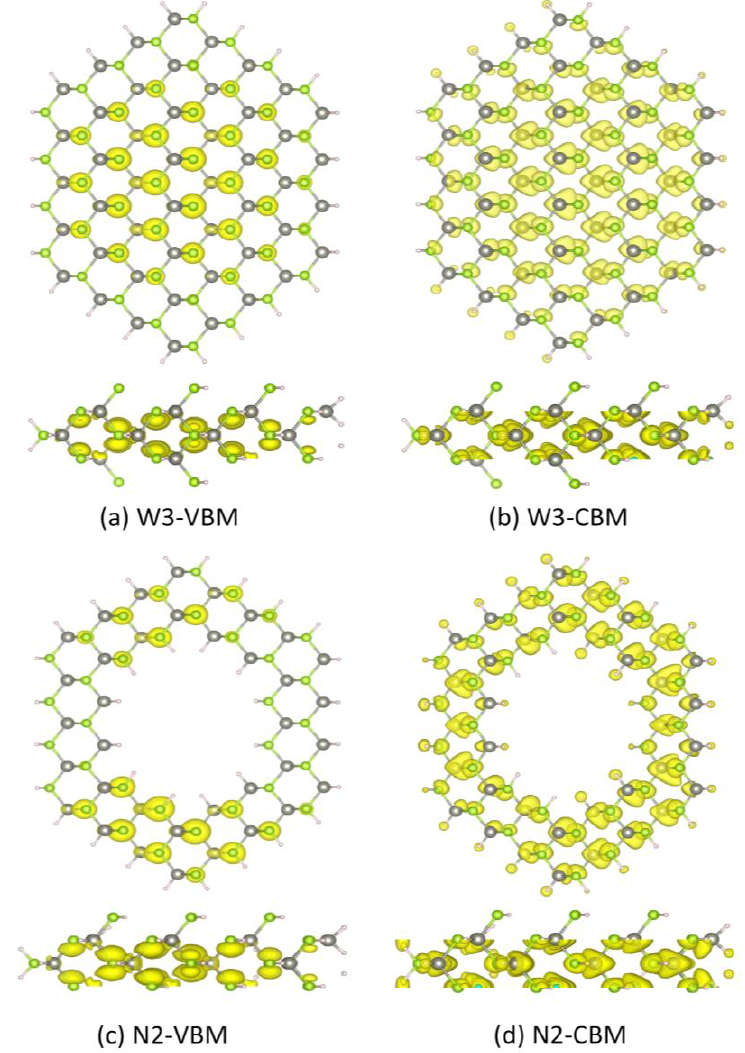
Figure 5. Partial charge density of the valence band maximum (VBM) and conduction band minimum (CBM) of ZnSe NWs (W3) and NTs (N2) at the G point. ( a )